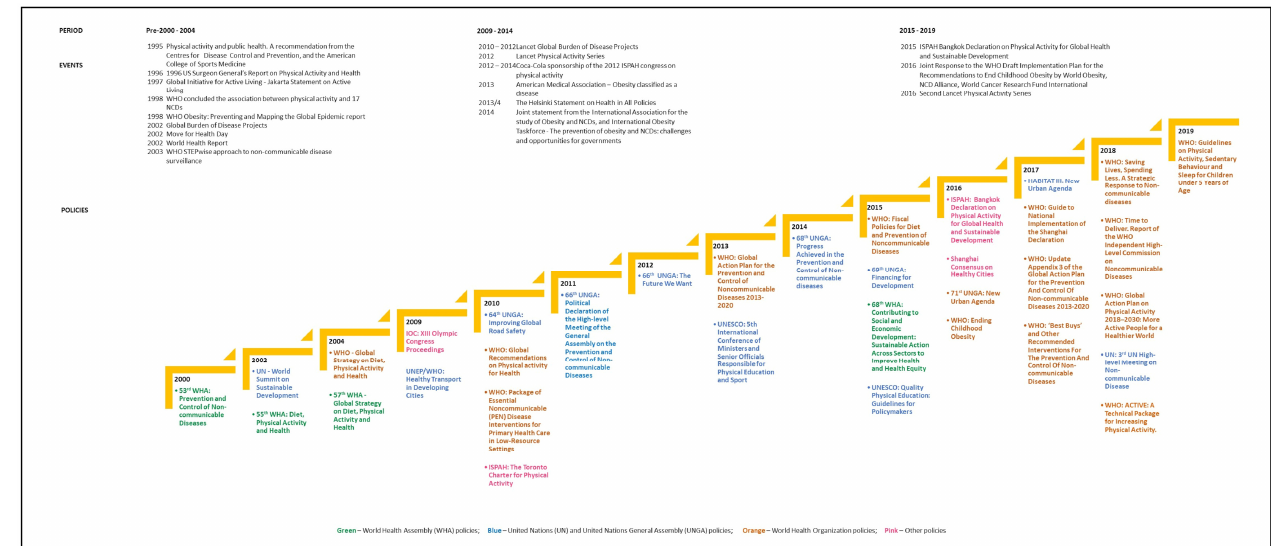
Figure 2. Global physical activity policies